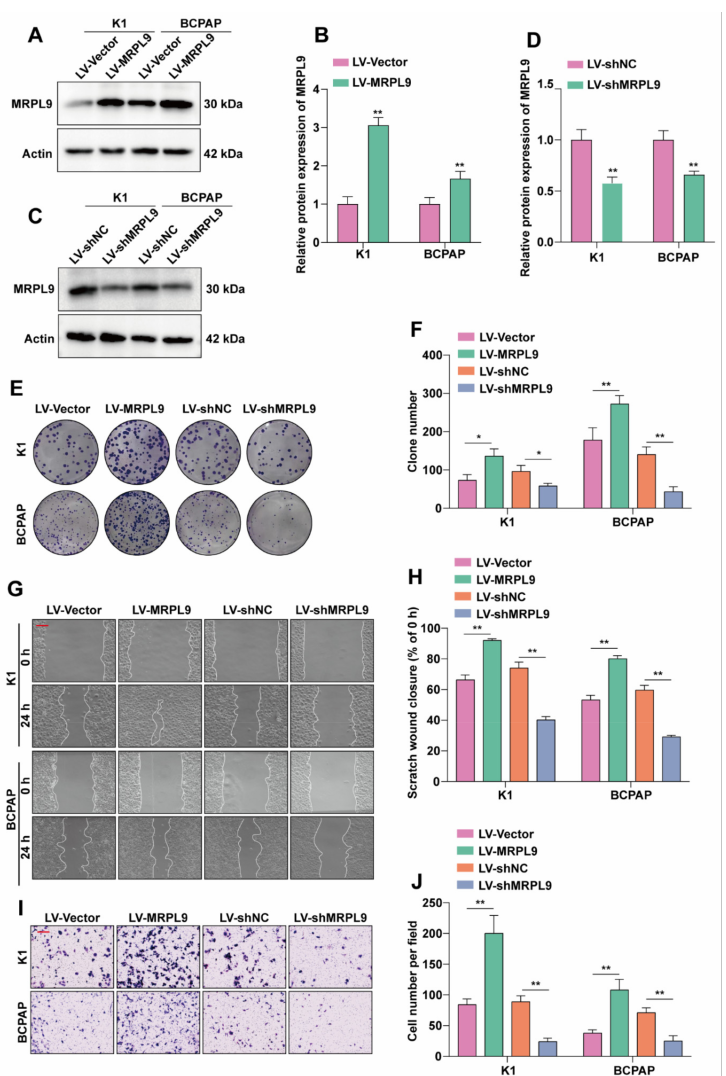
Figure 2. MRPL9 promotes the proliferation and migration of PTC cells. ( A ) K1 and BCPAP cell lines were infected with lentivirus containing LV-Vector, LV-MRPL9, and the overexpression efficiency of MRPL9 was detected by Western blot. ( B ) Western blot results were quantified and normalized to Actin ( n = 3). ( C ) K1 and BCPAP cell lines were infected with lentivirus containing LV-shNC and LV-shMRPL9, and the knockdown efficiency of MRPL9 was detected by Western blot. ( D ) Western blot results were quantified and normalized to Actin ( n = 3). ( E ) Colony formation assays assessed the effect of MRPL9 overexpression or knockdown on the proliferative capacity of K1 and BCPAP cells. ( F ) Statistical analysis of the number of cell clones was performed in image J ( n = 3). ( G ) The effect of MRPL9 overexpression or knockdown on the migration ability of K1 and BCPAP cells was examined by wound healing assay (scar bar = 100 µ m). ( H ) Statistical analysis of cell wound area was performed with image J ( n = 3). ( I ) Transwell assay to detect the effect of MRPL9 overexpression or knockdown on the migration ability of K1 and BCPAP cells (scar bar = 100 µ m). ( J ) Statistical analysis of cell numbers was performed with image J ( n = 3). Measurement data (mean ± standard deviation) between two groups were compared by paired t test. “*” represents p ≤ 0.05, “**” represents p ≤